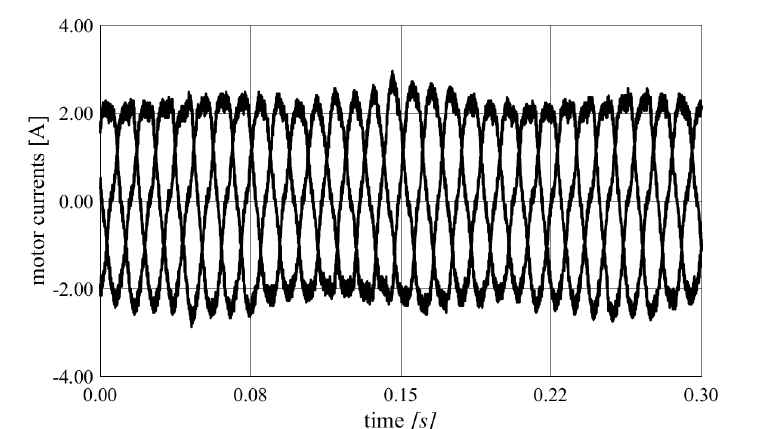
Figure 15. Experimental result: motor currents achieved with the traditional SVM, when m = 0.94, v ∗ = v ∗ = 200 V, and T l = 3.5 C1 C2